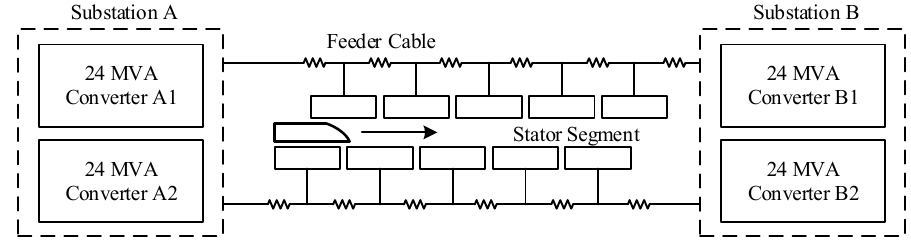
Figure 1. Double-end power supply mode.